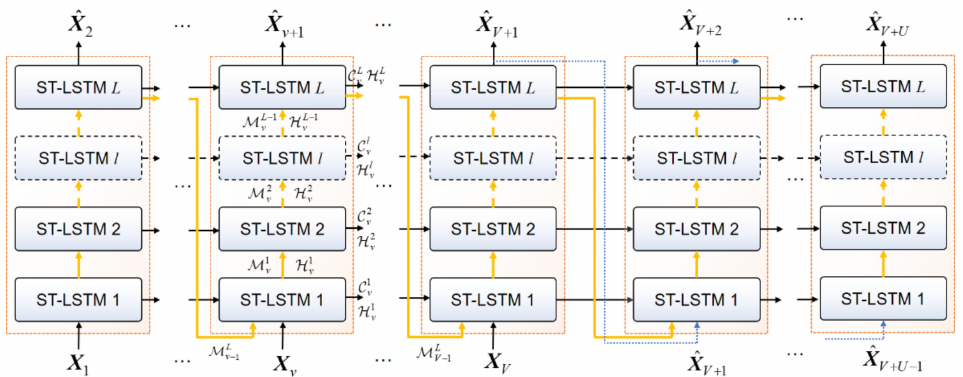
Figure 3. The network structure of a L -layer